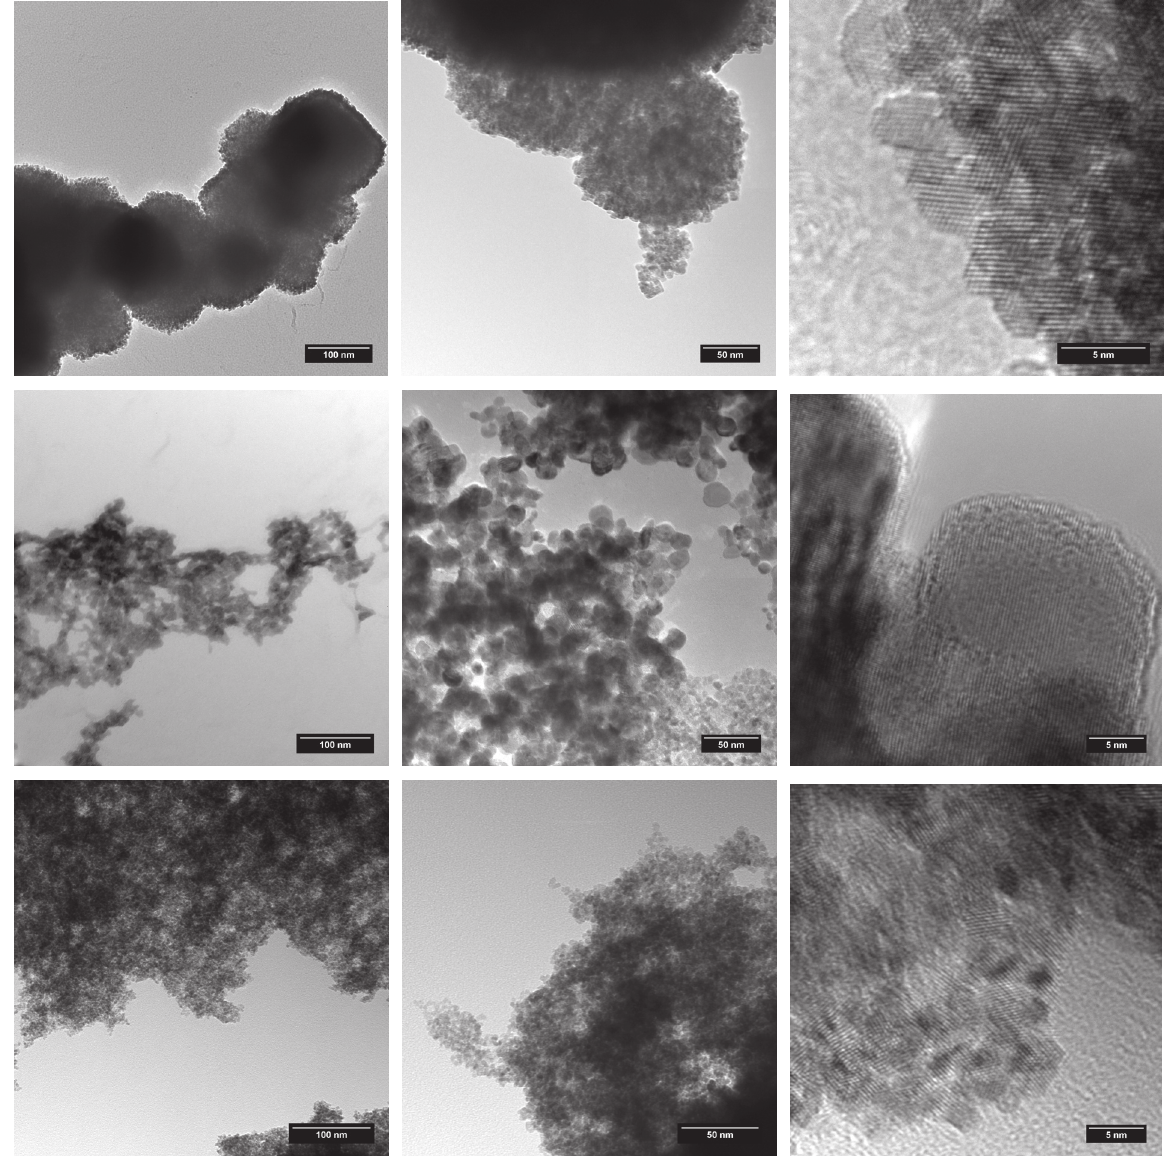
obtained by hydrothermal decomposition of the corresponding oxalate; a comparison Figure 2: TEM pictures of nanocrystalline An O 2 between ThO (top), UO (middle) and PuO 2 2 2